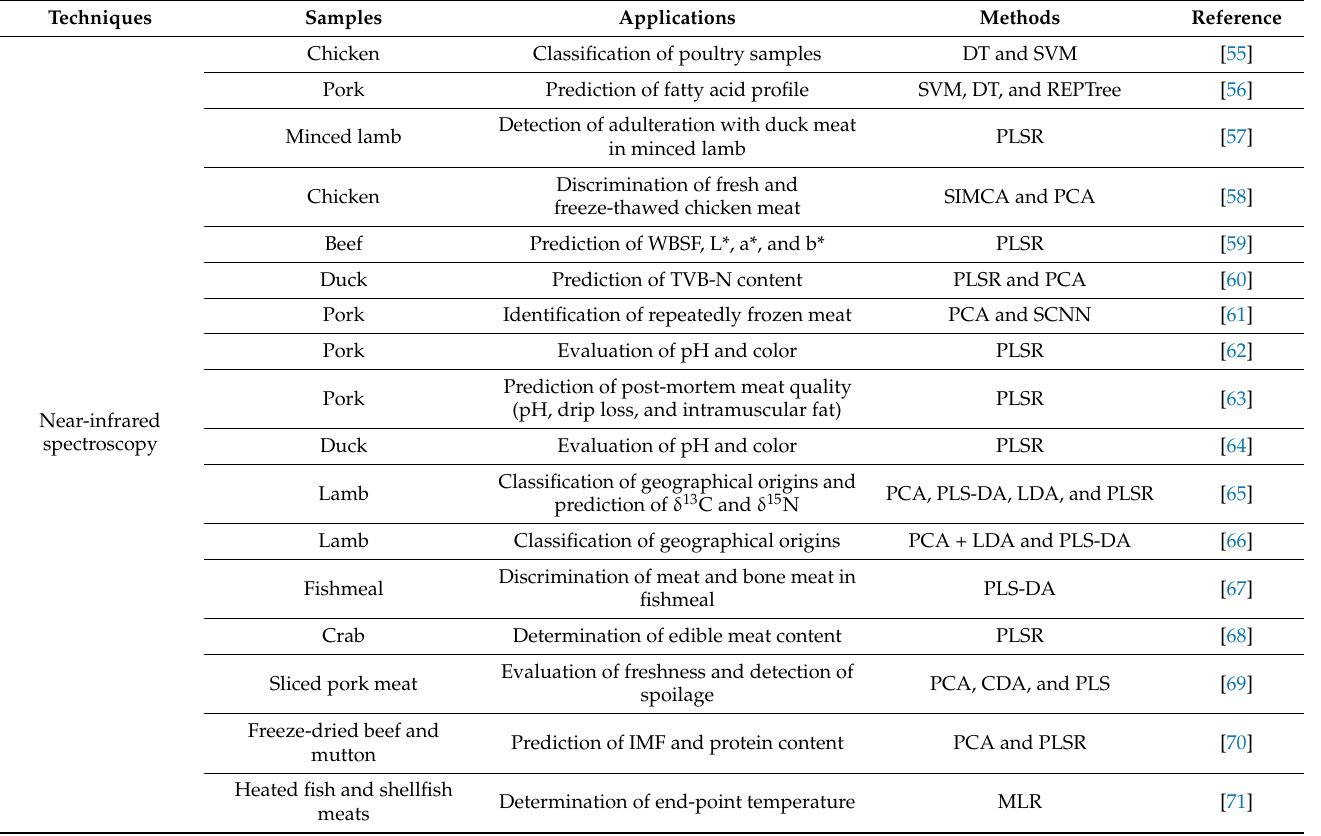
Table 1. Summaries of different spectroscopic techniques applied for meat